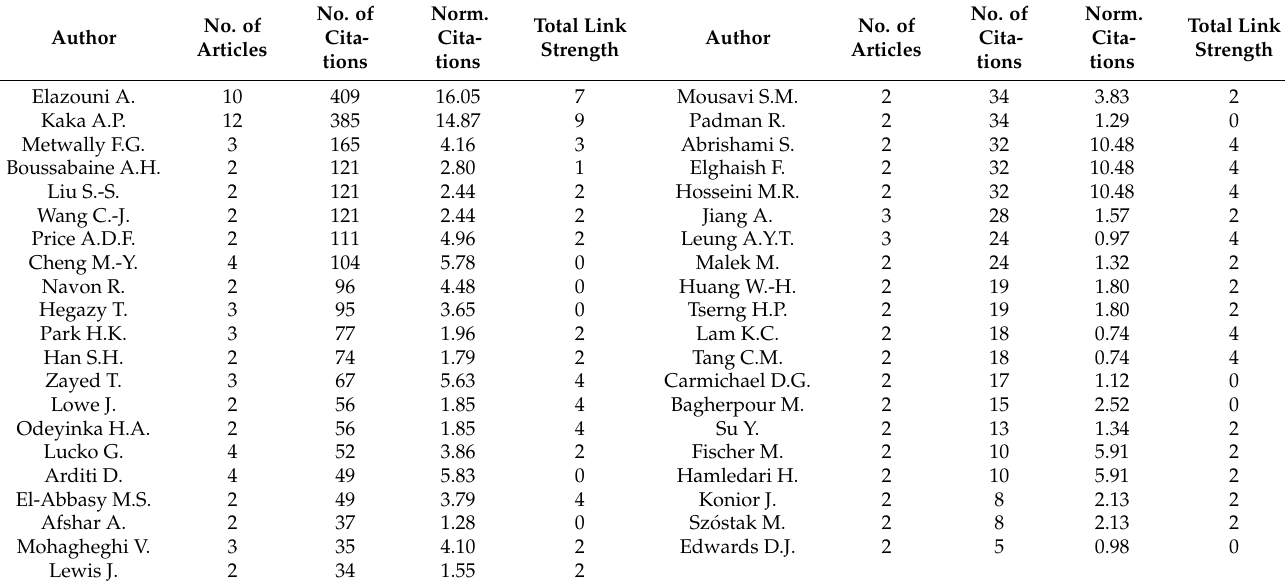
Table 1. Topmost contributing researchers in cash flow analysis